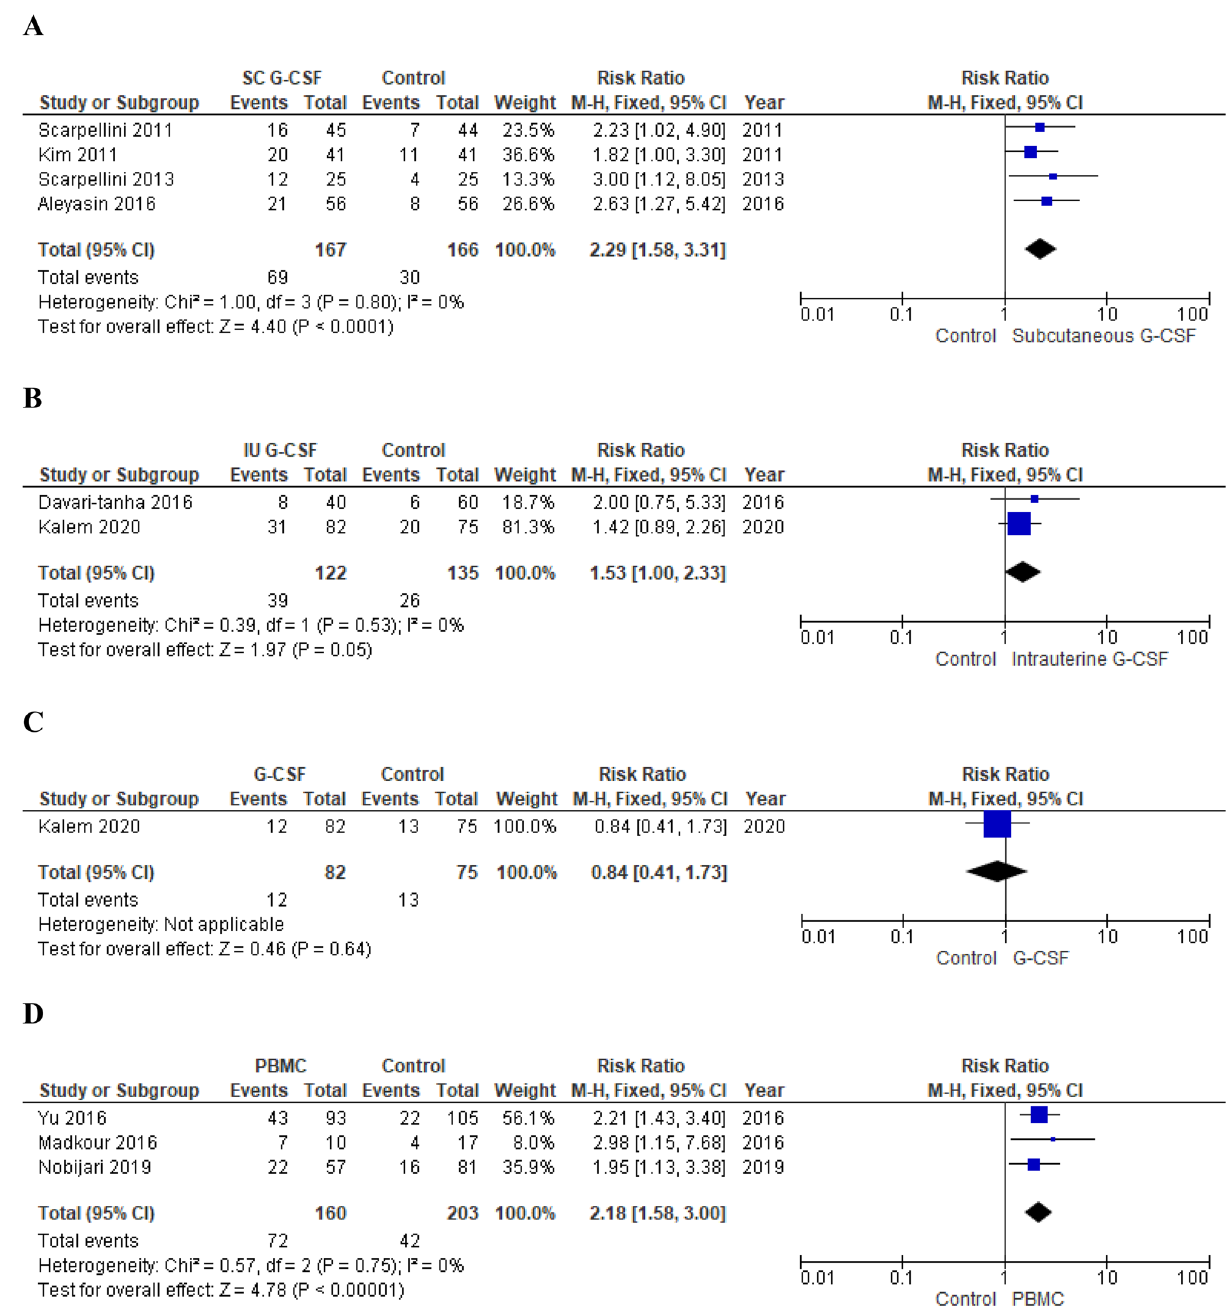
Figure 3. ( A ) Effect of subcutaneous G-CSF administration on CPR in women with RIF (RCTs). ( B ) Effect of intrauterine G-CSF infusion on CPR in women with RIF (RCTs). ( C ) Effect of subcutaneous G-CSF administration on LBR in women with RIF (RCT). ( D ) Effect of intrauterine PBMC infusion on CPR in women with RIF (RCTs). ( E ) Effect of intrauterine PBMC infusion on LBR in women with RIF (RCT). ( F ) Effect of intrauterine PBMC infusion on CPR in women with RIF (observational studies). ( G ) Effect of intrauterine PBMC infusion on LBR in women with RIF (observational studies). RIF repeated implantation failure, G-CSF granulocyte-colony stimulating factor, PBMC peripheral blood mononuclear cells, RCT randomized clinical trial, CPR clinical pregnancy rate, LBR live birth